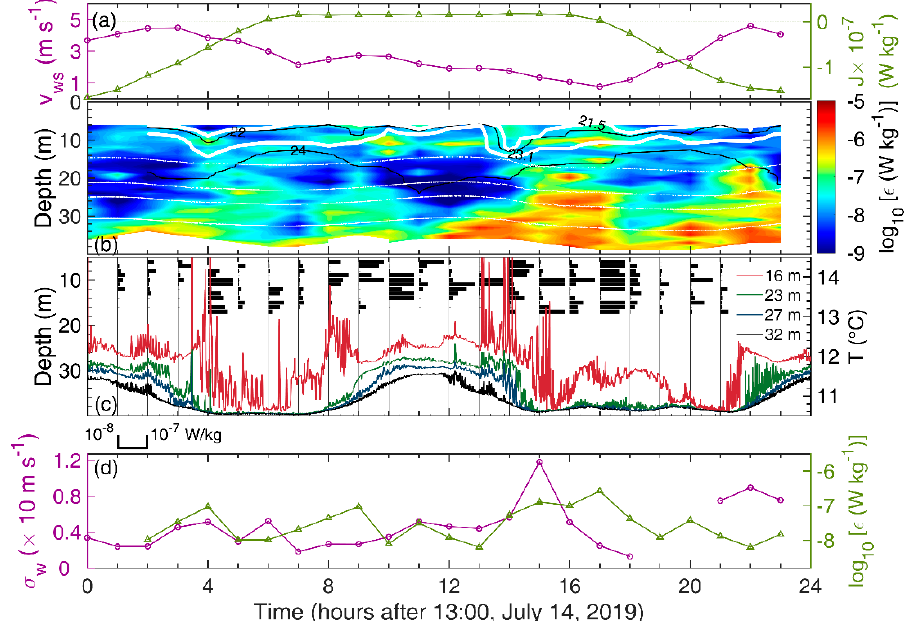
Figure 12. ( a ) Temporal variation of the wind speed (purple line) and buoyancy flux (green line). ( b ) Time − depth variation of 𝜀 with the isotherms (solid lines) superposed. White lines represent pycnocline boundaries. ( c ) The replotted 𝜀 around the pycnocline (black bars) and temperature. ( d ) Temporal variation of the averaged 𝜀 within the pycnocline (green line) and 1 h RMS vertical velocity (purple line).